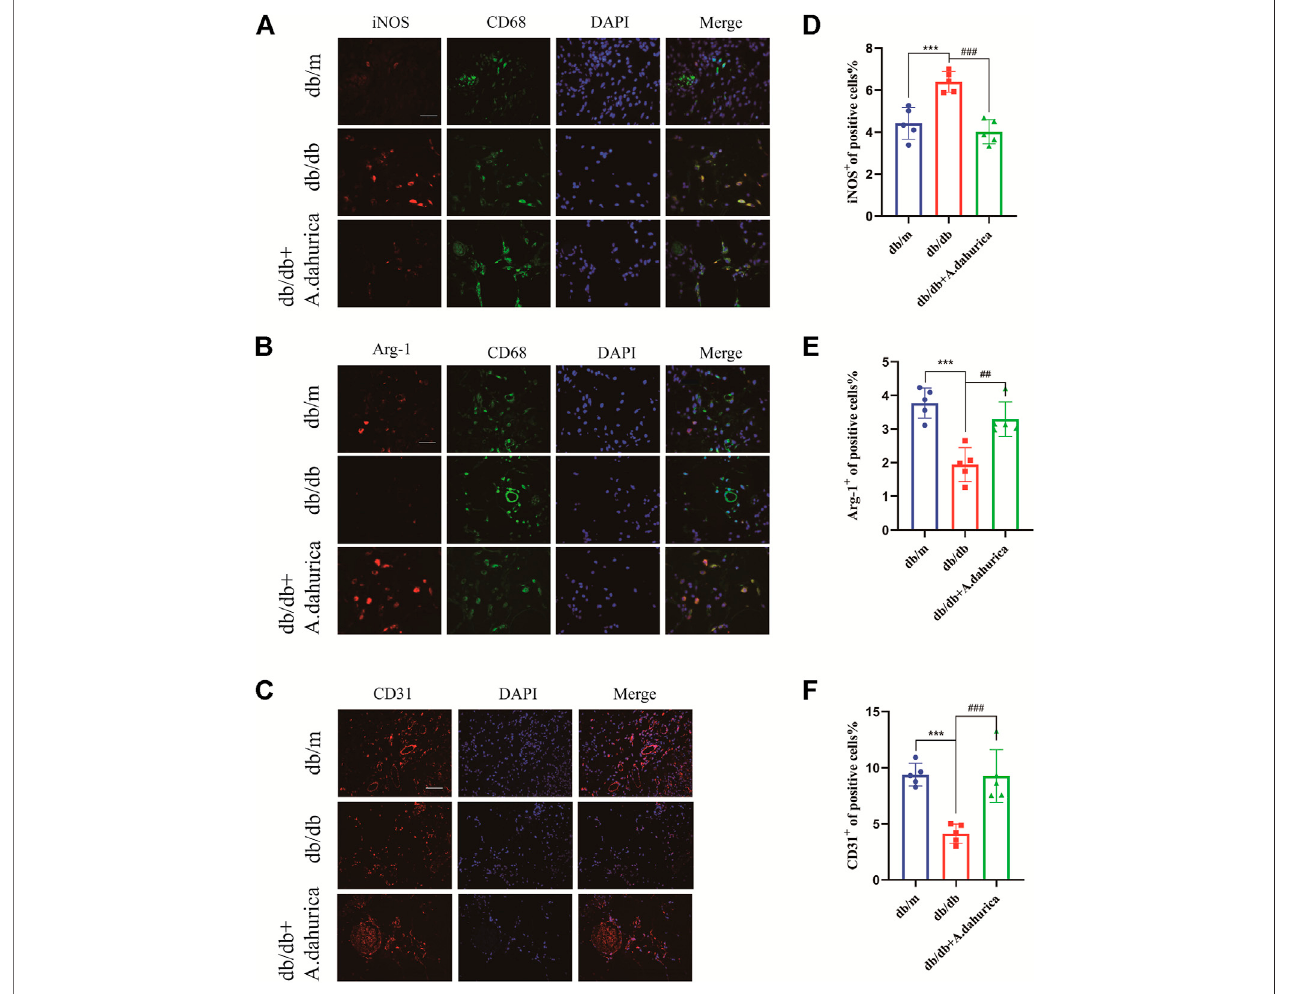
FIGURE5|(A) :Immuno fl uorescencestainingofiNOS(red)andCD68(green)inthewoundbed(scalebar:50 μ m). (B) :Immuno fl uorescencestainingofArg-1(red) and CD68 (green) in the wound bed (scale bar: 50 μ m). (C) : Immuno fl uorescence staining for CD31 in the wound vessels (scale bar: 50 μ m). (D – F) : Quanti fi cation of iNOS + cells, Arg-1+cells, and CD31 + cells in diabetic skin wounds. ( n (cid:2) 5 in each group). *** p < 0.001, ## p < 0.01, ### p < 0.001, * db/db vs. db/m group, # db/db + A. dahurica vs. db/db group.